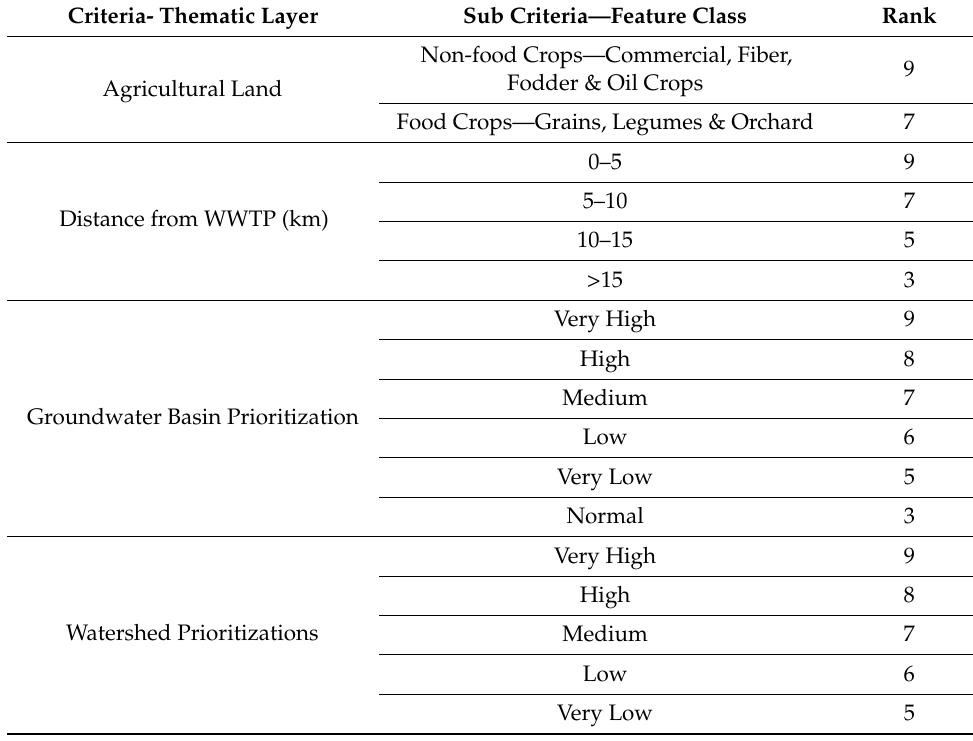
Watershed Prioritizations